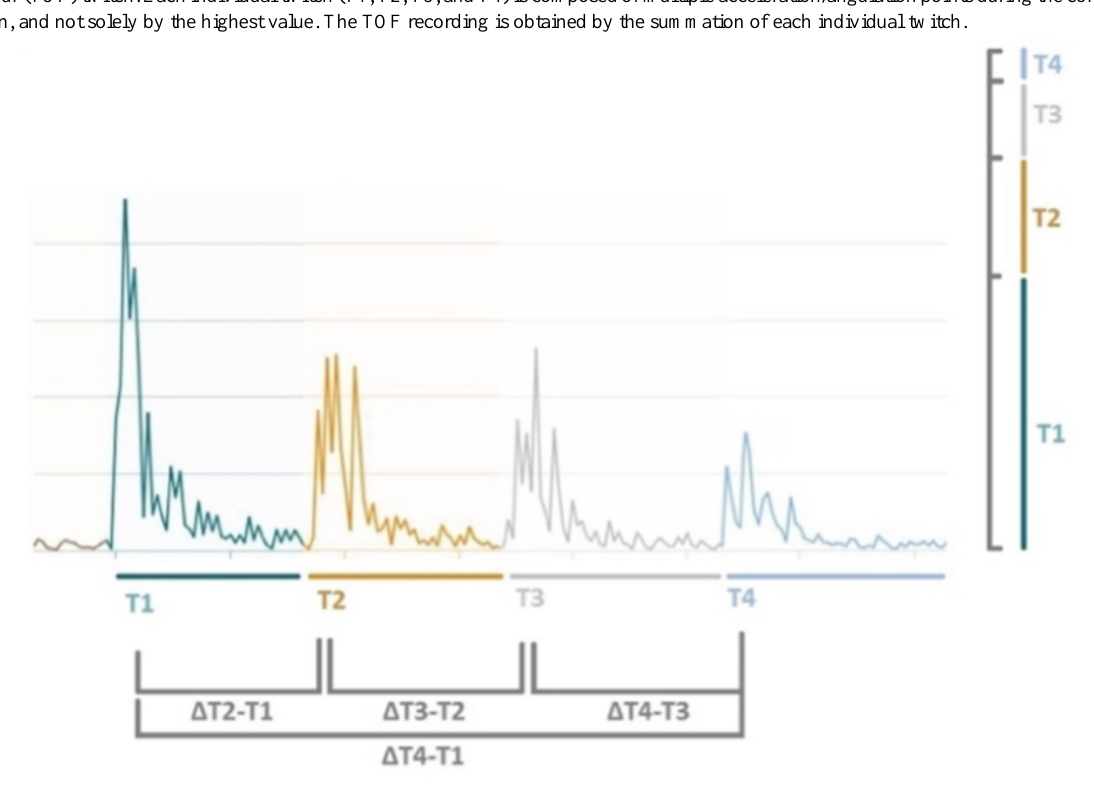
Figure 2. Basic and engineered feature illustration (x axis: time, y axis: combined angulation and acceleration). Each color represents an individual train-of-four (TOF) twitch. Each individual twitch (T1, T2, T3, and T4) is composed of multiple acceleration/angulation points during the corresponding contraction, and not solely by the highest value. The TOF recording is obtained by the summation of each individual